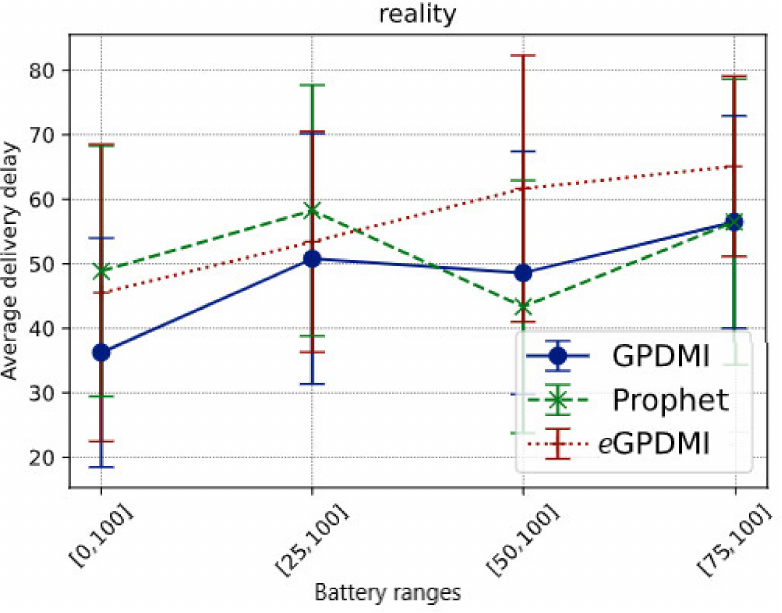
Figure 7. Average delivery delay vs. battery ranges in Reality